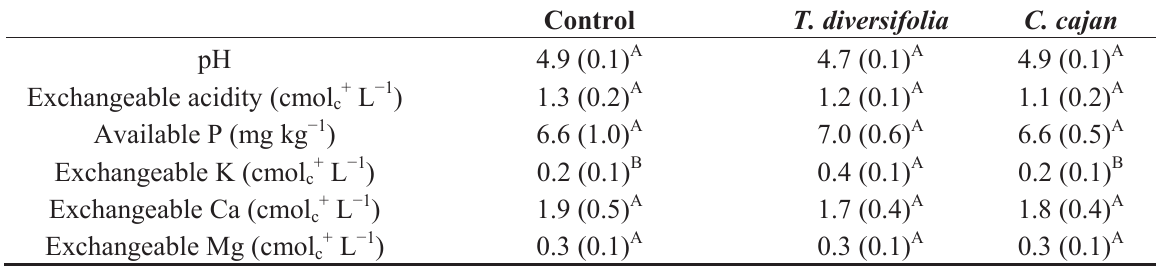
Table 1. Soil chemical characteristics (0–12 cm) of an Andosol at the bean flowering phase in treatments with no mulch or mulch biomass from T. diversifolia and C. cajan in a Costa Rican Andosol. Standard errors are given in